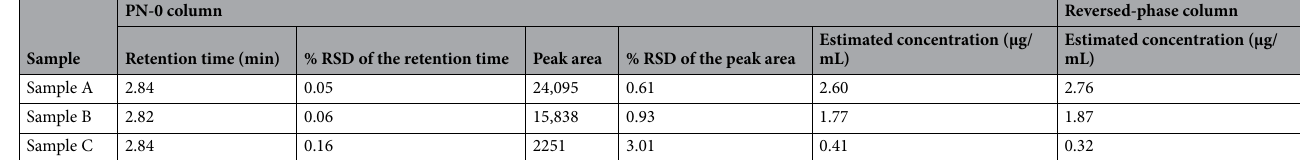
Table 2. Retention times and peak areas of voriconazole in three clinical samples ( n =